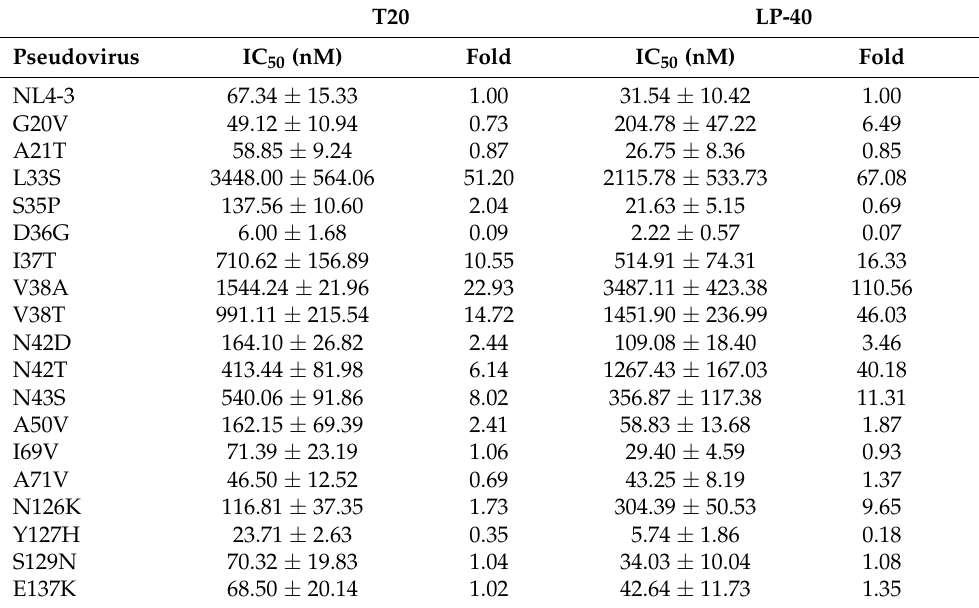
Table 2. Resistance profiles of HIV-1 mutants to T20 and LP-40. The experiment was performed in triplicate and repeated three times. Data are expressed as means ± SD. Fold change in the IC 50 was determined relative to the WT (HIV-1 NL4-3 )